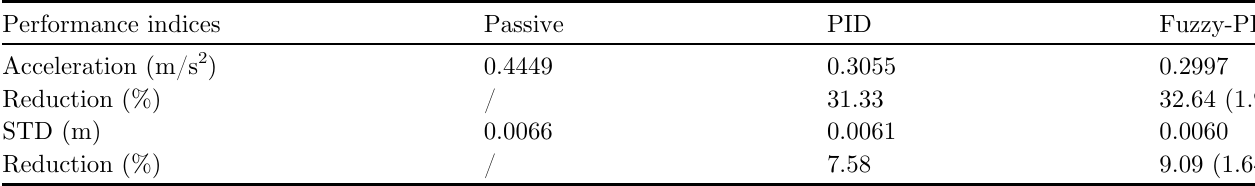
Fig. 10. Time domain characteristics of the seat suspension system under random excitation: (a) seat acceleration; (b) seat travel stroke. Table 6. RMS values under random road pro fi le.